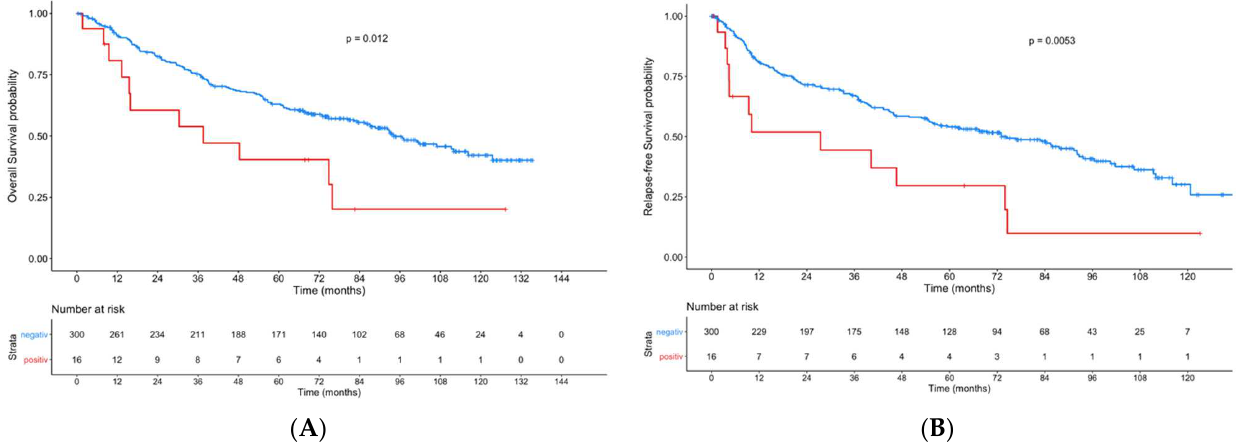
Figure 3. Kaplan–Meier curves showing overall survival ( A ) and recurrence-free-survival ( B ) in patients with an ERα- positive lymph node metastasis and/or primary tumor compared to patients with ERα-negative tumors.